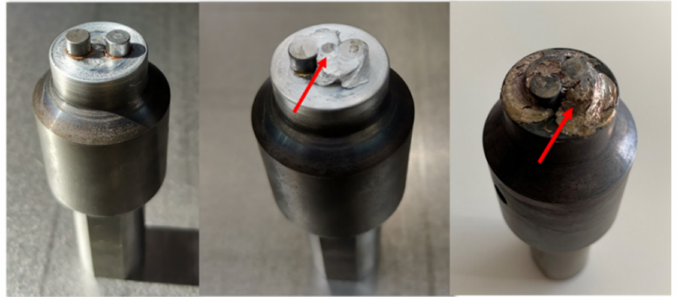
Figure 7. Two-pin tool ( left ), after aluminium welding ( centre ), after copper welding ( right